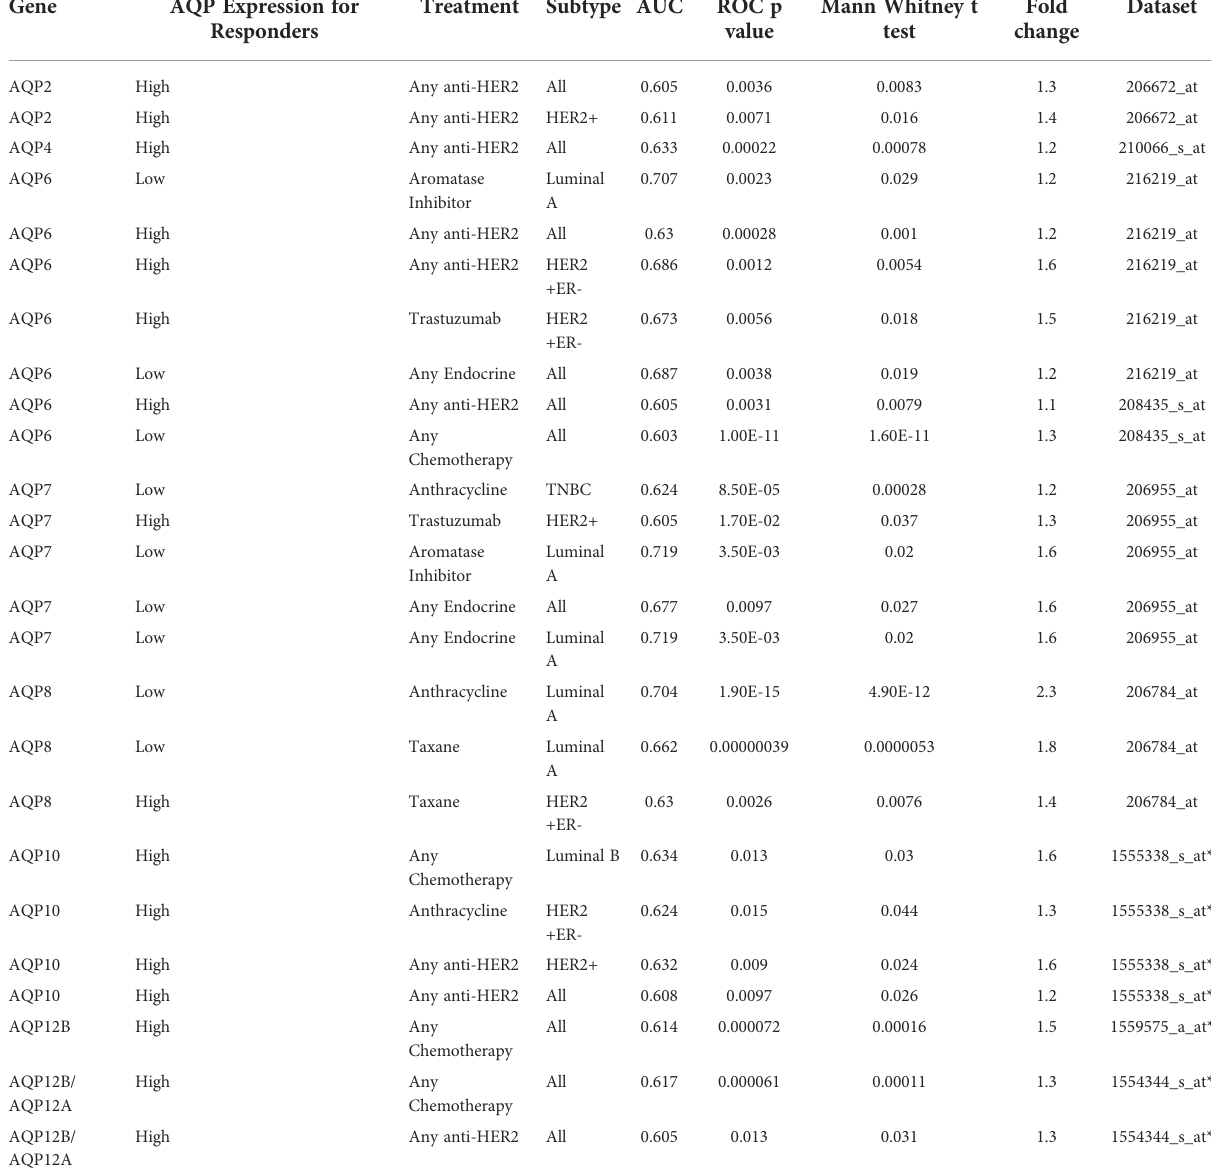
TABLE 2 ROC Analysis of Pathological Complete Response of AQPs for Breast Cancer. ROC Plotter links gene expression and response to therapy using transcriptome-level data of breast cancer patients. Gene AQP Expression for